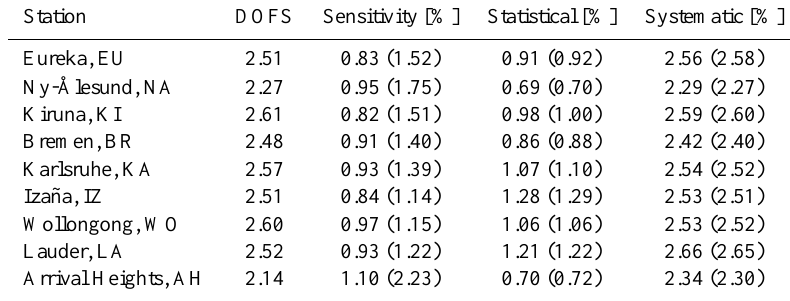
Table 3. Typical DOFS for the CH 4 FTIR retrievals and typical sensitivity errors (root-square-sum of ns, tro, and utls), total statistical errors, and total systematic errors for the lower tropospheric column-averaged CH 4 amounts. The error values are calculated according to the assumed uncertainty and statistical/systematic partitions as given in Table 2 and are for the a posteriori corrected retrievals as described in Sect. 2.3.3. The error values obtained without the a posteriori correction are given in parentheses.